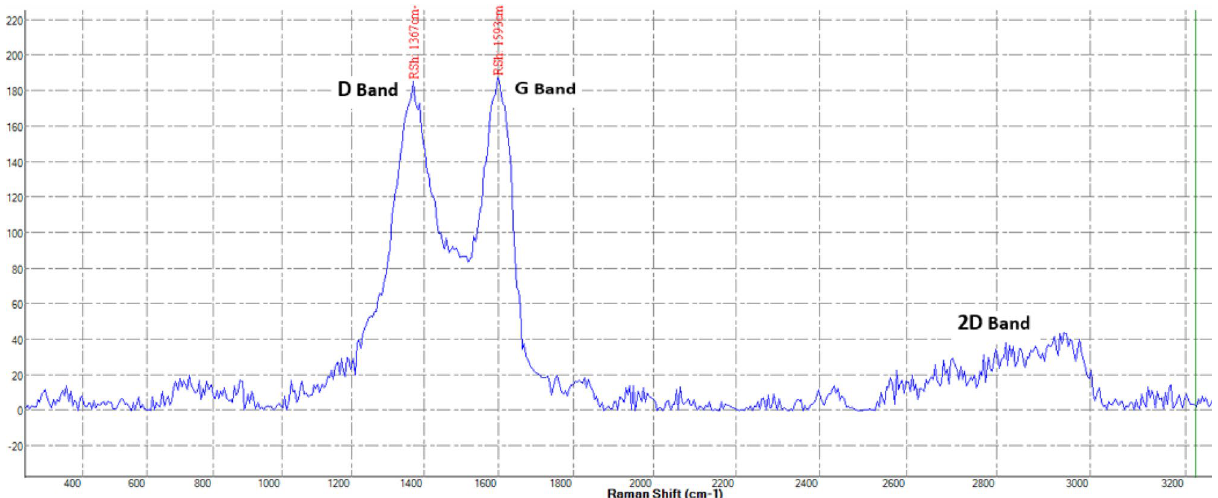
Figure 3. Raman spectrum of the Col-rGO scaffolds showing D, G and 2D bands.